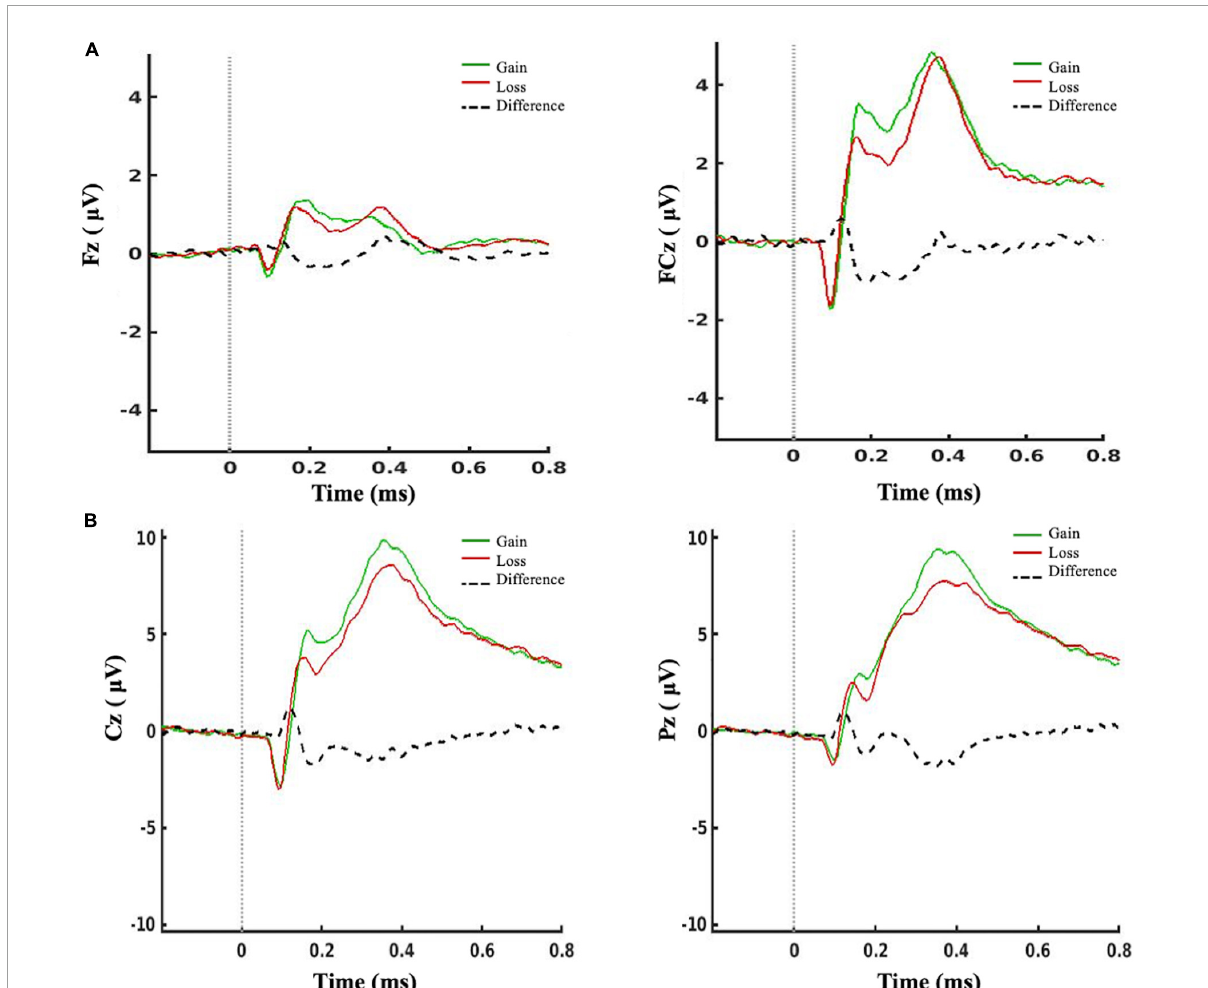
FIGURE2 ERPs for gain feedback (in green), loss feedback (in red) conditions, and the mean difference of loss minus gain feedback (black dotted line). (A) The RewP (200–300 ms after feedback presentation) was measured at a frontal and a frontocentral cluster. (B) The FB-P3 (300–600 ms after feedback) was measured at a central and a centroparietal